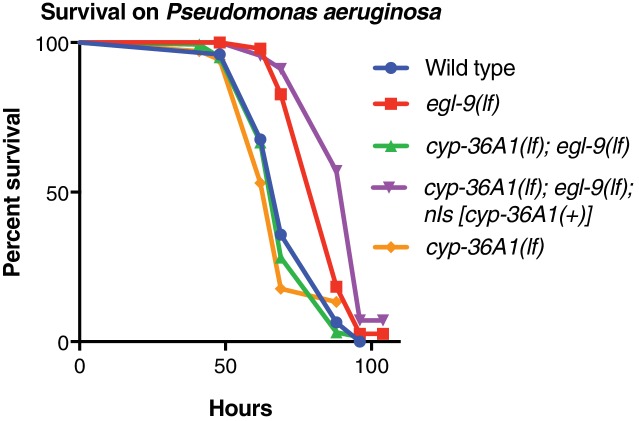
Replicate data for survival on Pseudomonas aeruginosa.Replicate data for Figure 2C. Wild type (n = 150) vs. egl-9(lf) (n = 50), p<0.001; egl-9(lf) vs. cyp-36A1(lf); egl-9(lf) (n = 163), p<0.001; cyp-36A1(lf); egl-9(lf) vs. cyp-36A1(lf); egl-9(lf); nIs [cyp-36A1(+)] (n = 51), p<0.001; wild type vs. cyp-36A1(lf) (n = 35), p>0.05, as determined by the log-rank (Mantel-Cox) test, correcting for multiple comparisons with the Holm-Bonferroni method.